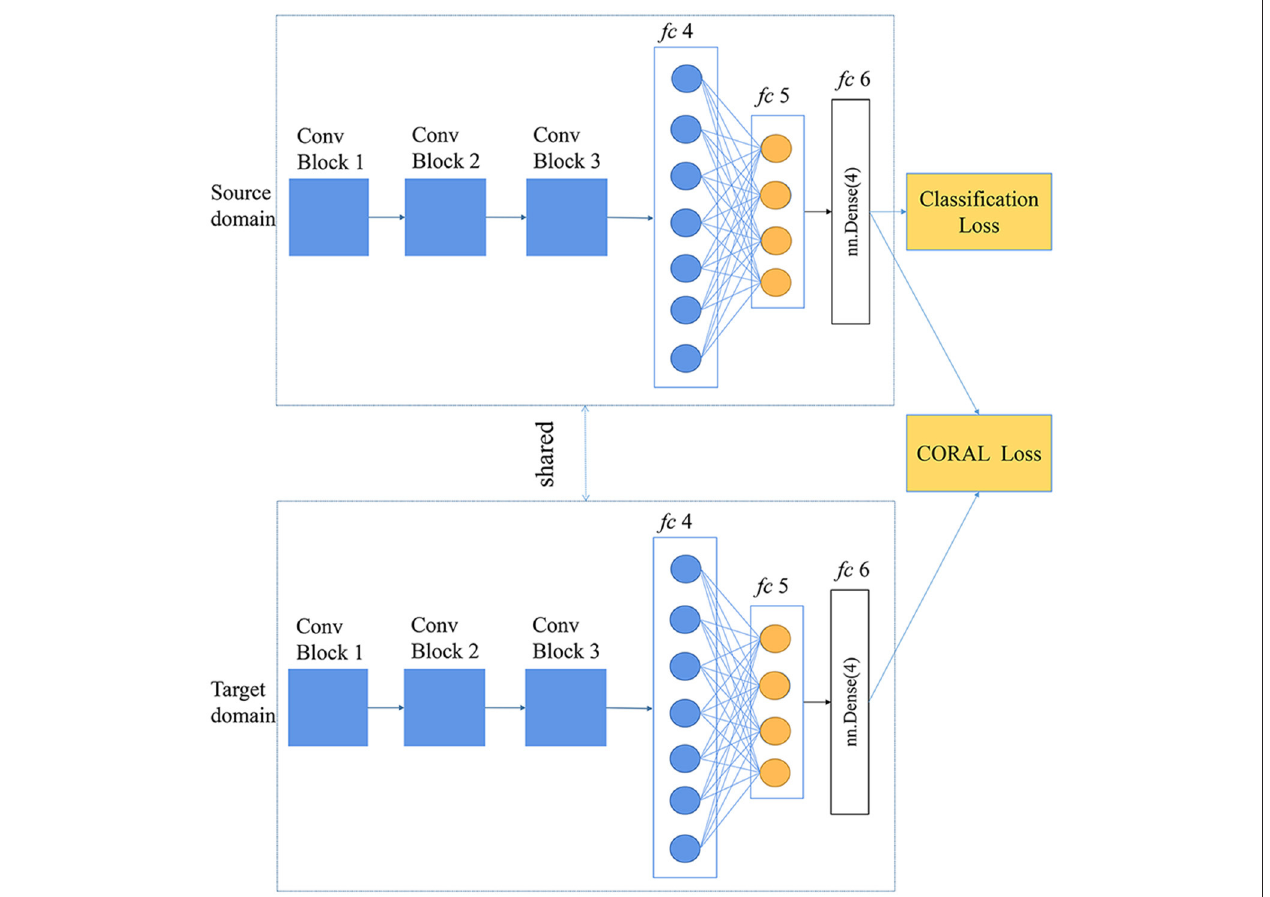
FIGURE 3 | Deep CORAL architecture based on a self-designed